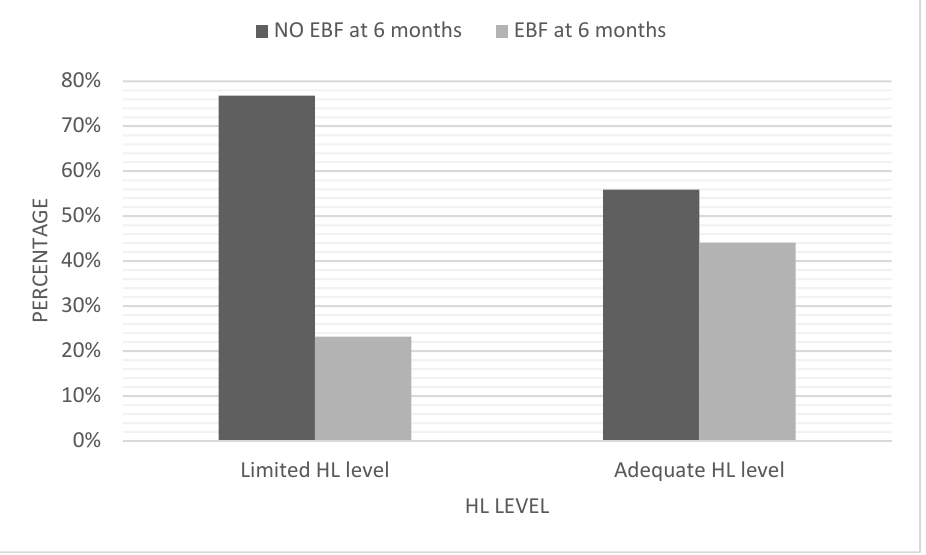
Figure 2. Distribution of HL levels in relation to EBF at 6 months (N = 343). Table 3. Factors related to EBF cessation before 6